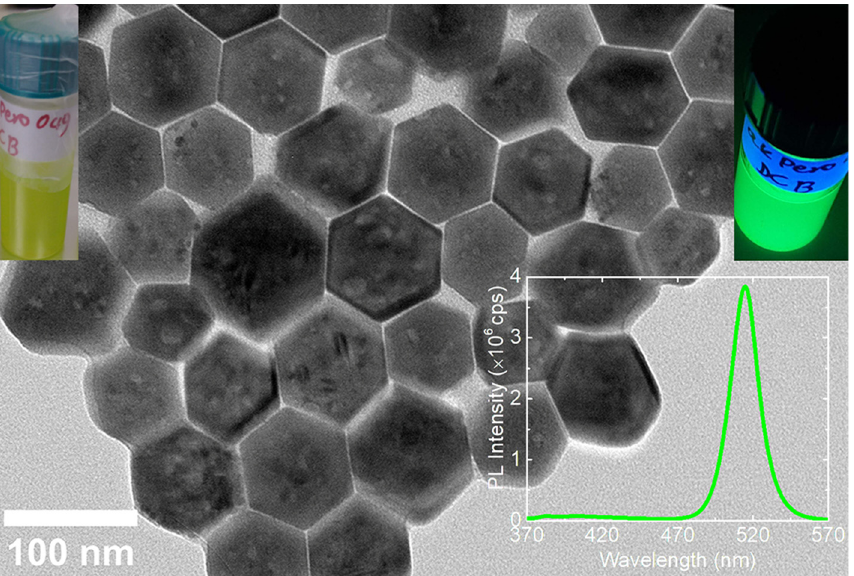
Figure 2. Low magnification transmission electron microscopy (TEM) image of the pristine cesium lead bromide nanohexagons before the laser irradiation. Insets: Photo of DCB-based solution of the nanohexagons ( upper left ), the same solution under UV lamp ( upper right ) and its PL spectrum ( bottom right